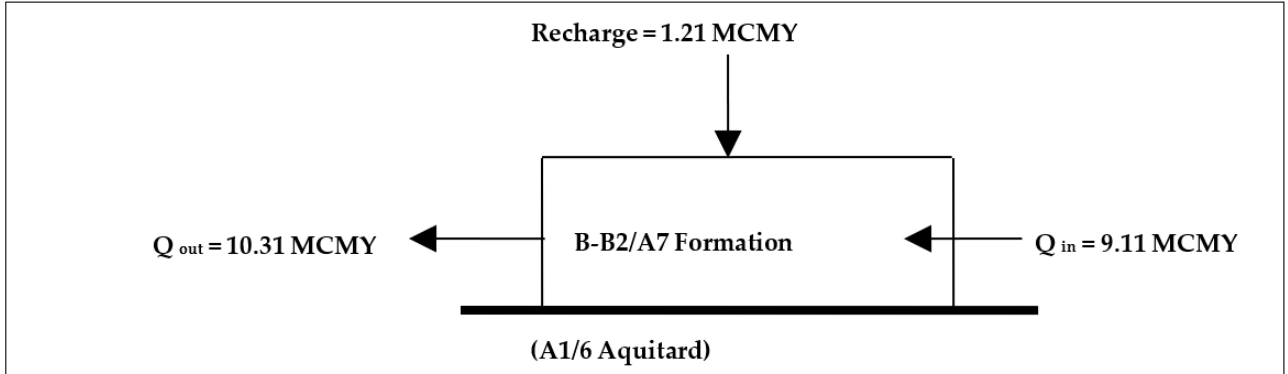
Figure 9. Water balance of the model domain at the steady-state conditions.